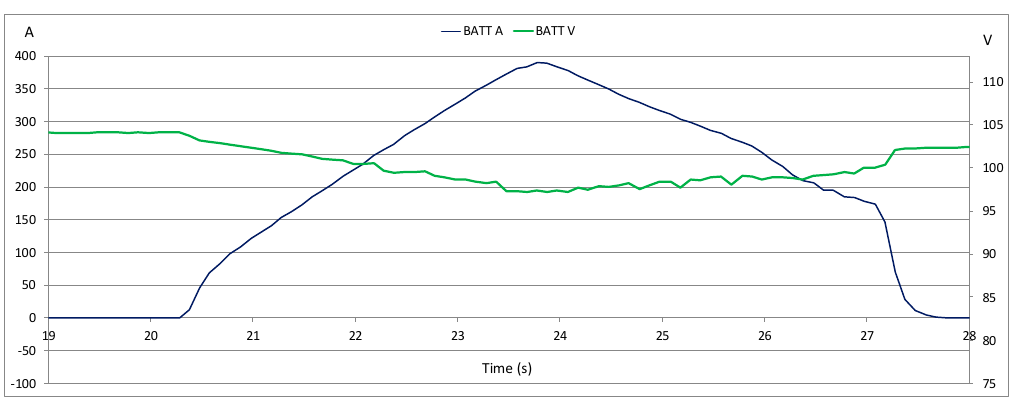
Figure 13. Test bench results.